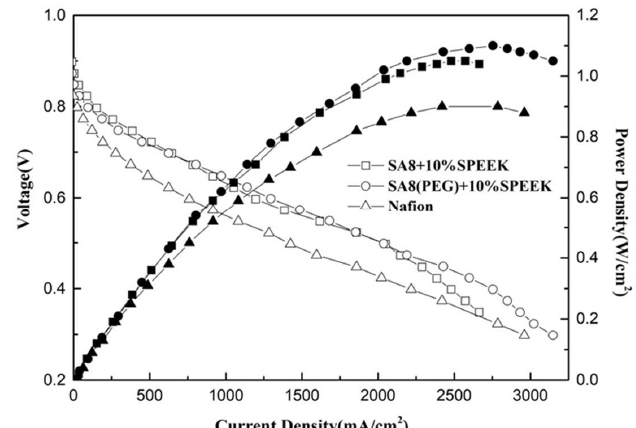
Figure 23. Fuel cell component performance diagram of SA8 blended with PEG and 10% sPEEK.